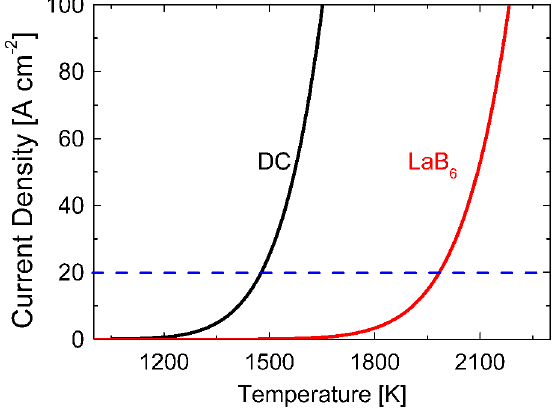
FIG. 3. Ideal emission of DC and LaB using Eq.